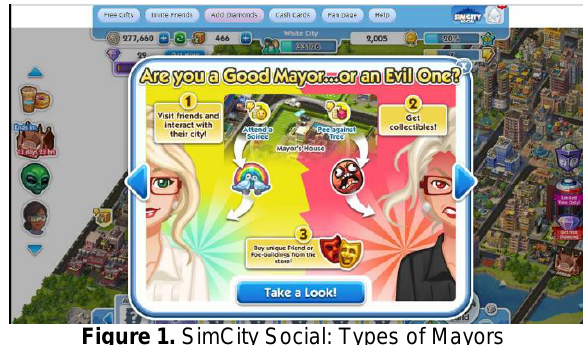
Figure 1. SimCity Social: Types of